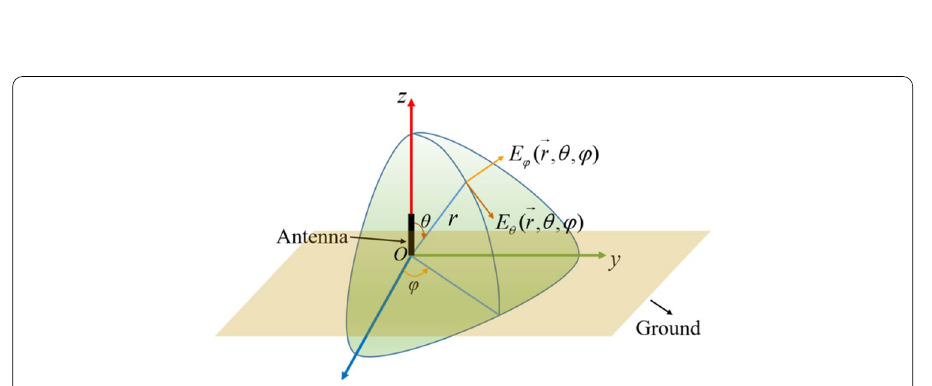
Fig. 2 Schematic diagram of simple antenna radiator. The monopole antenna is placed on the infinite ground. The far radiation field is orthogonal decomposed into E θ and E